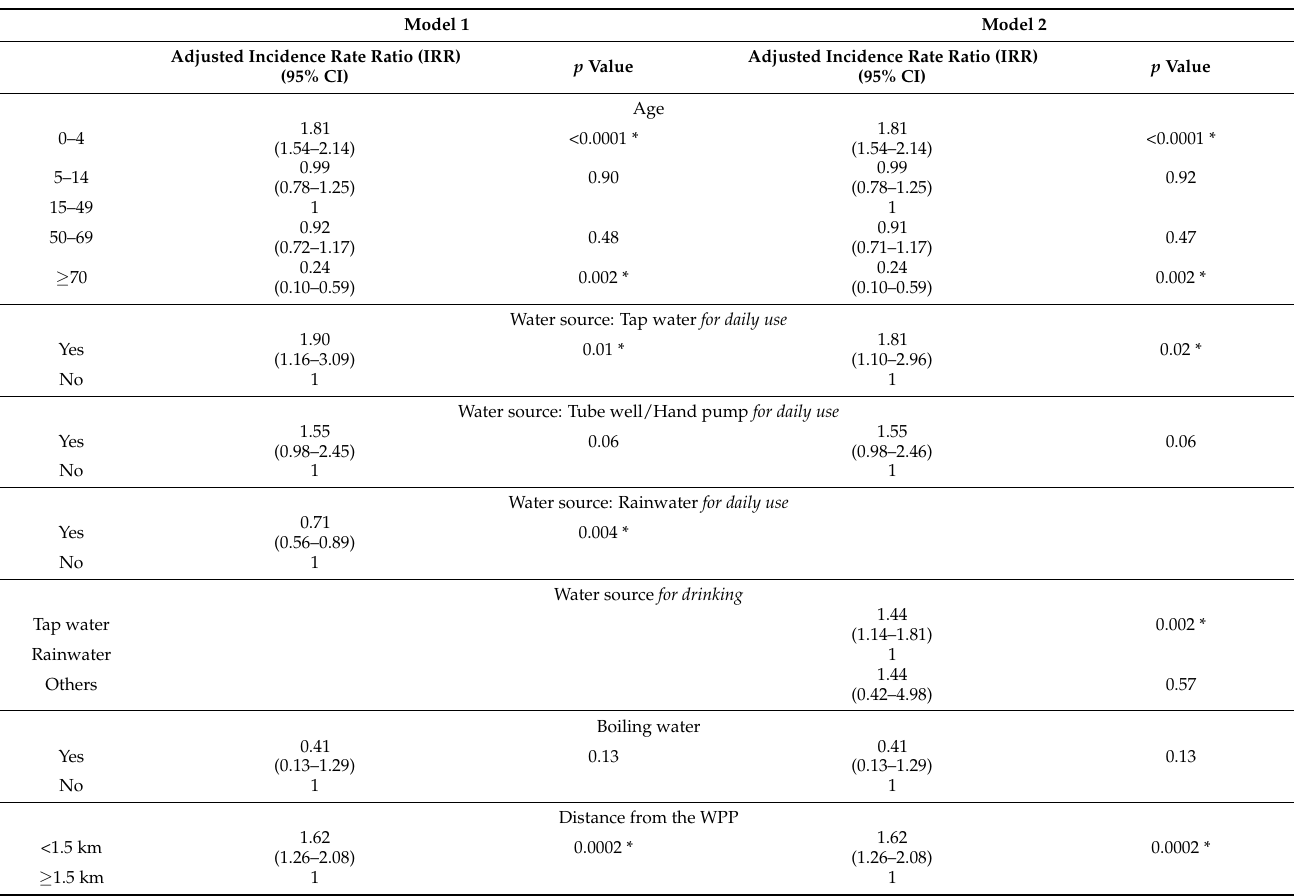
Table 3. Multivariate NB-GLMM of risk factors using the data in this study period (54 weeks). “Household” was included as a random